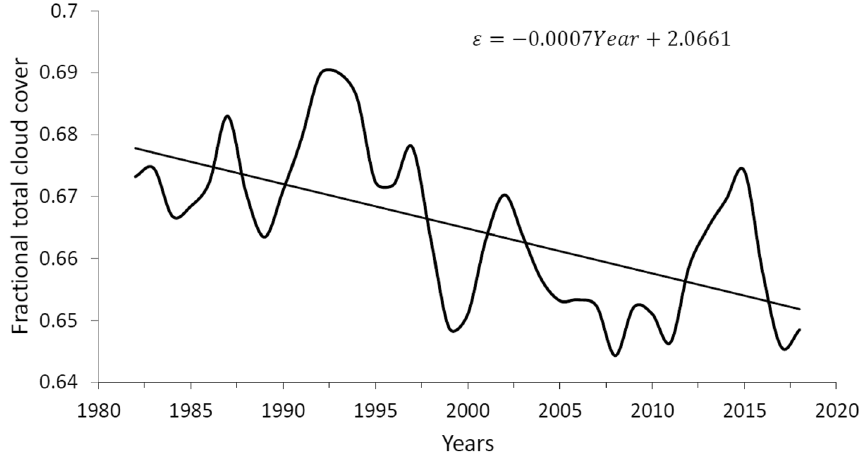
Figure 3. Global and annual average of total cloud cover during the 37-year period from 1982 to 2018, obtained from the CLARA-A2.1 monthly global database with a 25-month running average, thus reducing its deviation standard 2.97 to 1.28 pp.